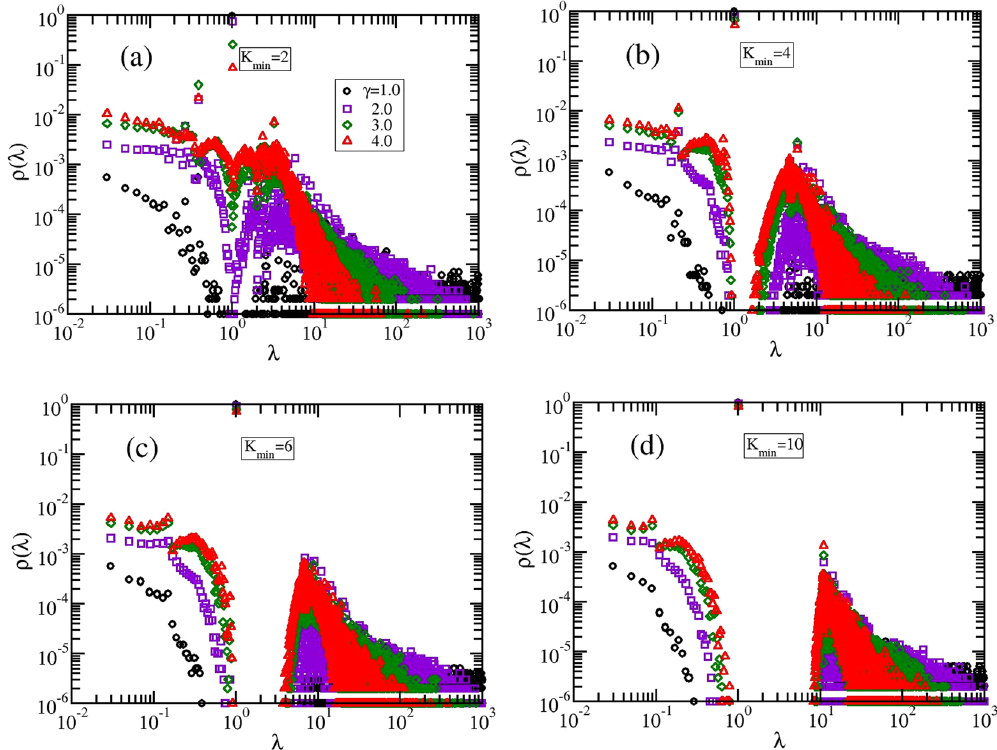
Figure 5. Eigenvalues density for GSFPNs with N = K max + 1 = 1000 and different K min